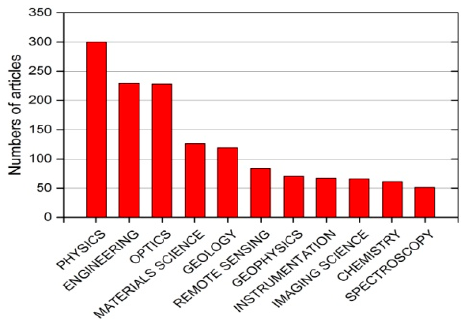
Figure 1. Literature statistics for bidirectional reflectance distribution function (BRDF) modeling over rugged terrain contributed by different research field in recent decades.